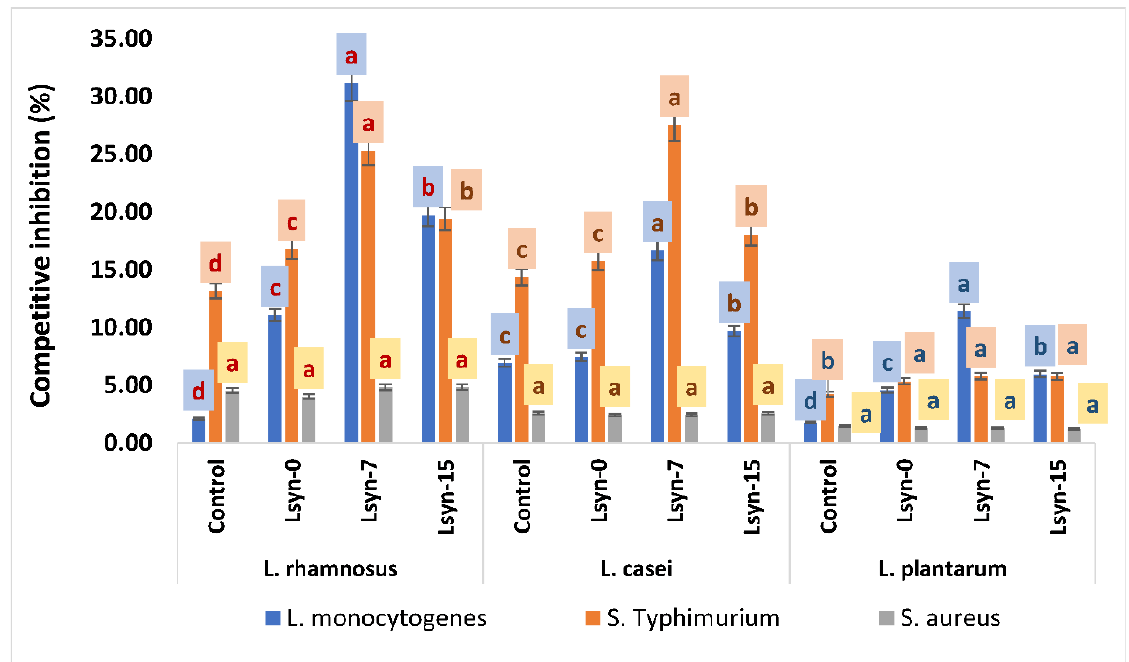
Figure 5. The influence of postbiotics (L syn-0 , L syn-7 and L syn-15 ) on competitive inhibition to adhere S. aureus , S. Typhimurium and L. monocytogenes to Caco-2 cells by lactobacilli strains. Different letters indicate significant differences at p < 0.05. The Error bars show the standard division of the sample ’ s mean.